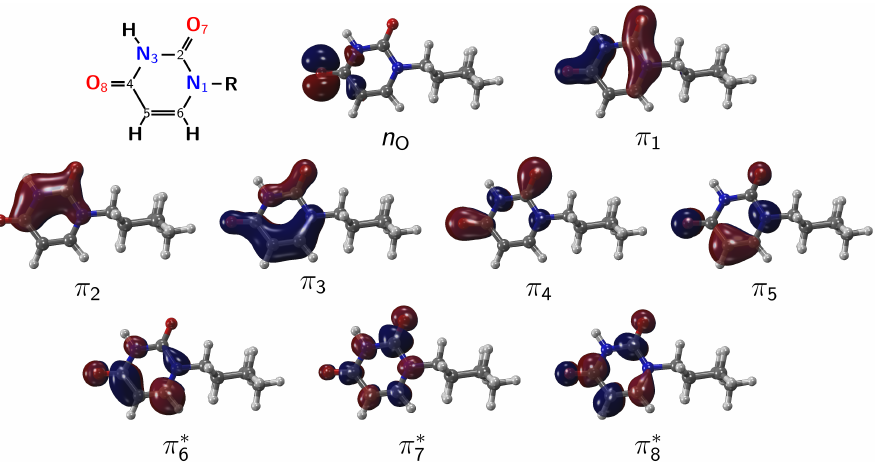
Figure 4. Active space employed during geometry optimizations and vertical excitation energies calculations, encompassing twelve electrons and nine orbitals. The orbitals were obtained in terms of state-averaged valence natural orbitals calculated at the SA(3S+3T)-CASSCF level in the ground-state equilibrium geometry.